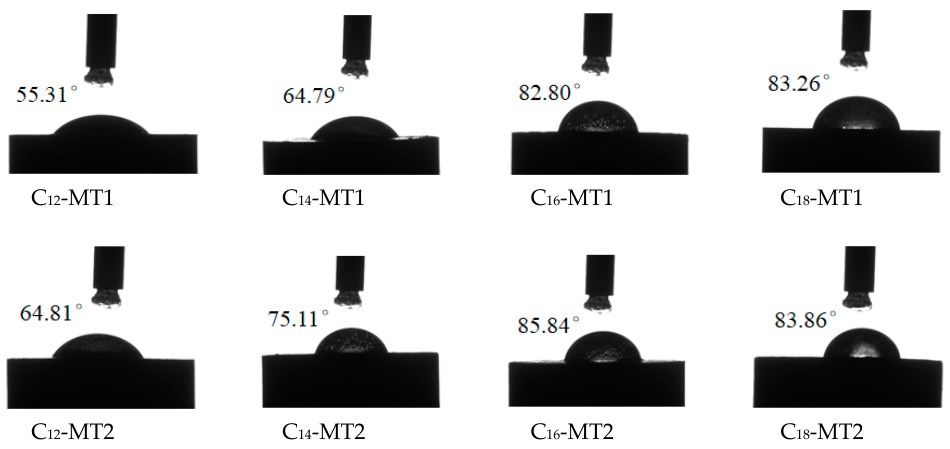
Figure 5. Contact angle of organo-MT.